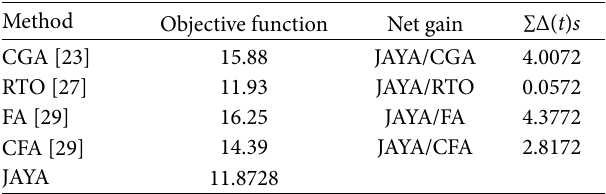
Table 7: Primary/backup relationships and total fault current of the